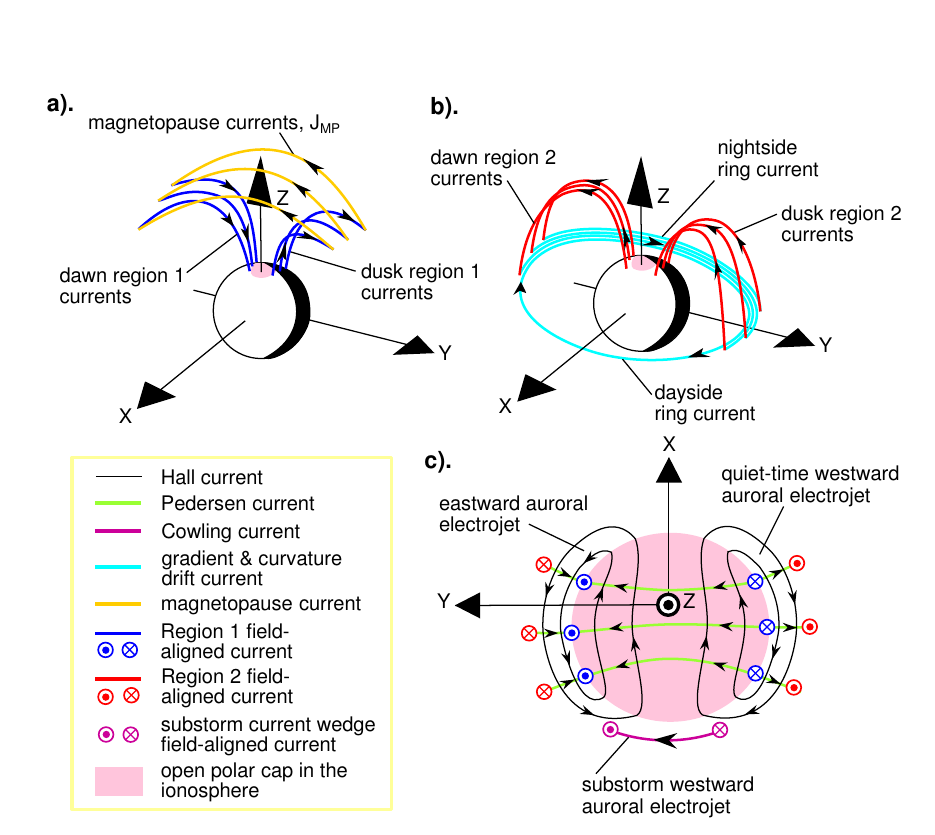
Figure 2: Simplified schematic of the currents flowing in the magnetosphere-ionosphere system in the northern hemisphere (southern hemisphere currents are omitted for clarity). Part (a) shows (in orange) segments of the Chapman–Ferraro currents that flow in the magnetopause and separate the geomagnetic and (shocked) interplanetary fields: the relevant segments are at the sunward edge of the magnetospheric tail and flow from dusk to dawn (see also Figure 14). These connect to the high-latitude ionosphere via the Region 1 field-aligned (Birkeland) currents (shown in blue). The Region 2 field-aligned currents are needed to maintain ionospheric current continuity and because of the incompressibility of the ionosphere (in the sense that the magnetic field there is essentially constant). As shown in red in (b), these Region 2 currents close via the ring current that flows westward around the Earth in the inner magnetosphere (in cyan), caused by the gradient and curvature drifts of trapped energetic particles. Part (c) shows the Region 1 and 2 currents entering and leaving the polar E-region ionosphere and how they connect to the Pedersen currents there (in green), which flow in the direction of the electric field. The paired up and down field- aligned currents transfer solar wind energy, momentum, and electric field down into the ionosphere as well as current (see review by Lockwood, 1997). The Hall currents (shown by black lines) flow perpendicular to the electric field (and so cause no energy dissipation) and are antiparallel to associated ionospheric flow (convection) in the over-lying F-region ionosphere. For a uniform spatial distribution of conductivities, the effects of field-aligned and Pederson currents cancel beneath the ionosphere and only the Hall currents are detected by high-latitude magnetometers on the ground. The formation of the westward electrojet in the substorm current wedge (shown here in mauve) is described later by Figure 14. In this electrojet, a highly conducting channel is formed by ionisation generated by the associated particle precipitation and the Cowling conductivity is